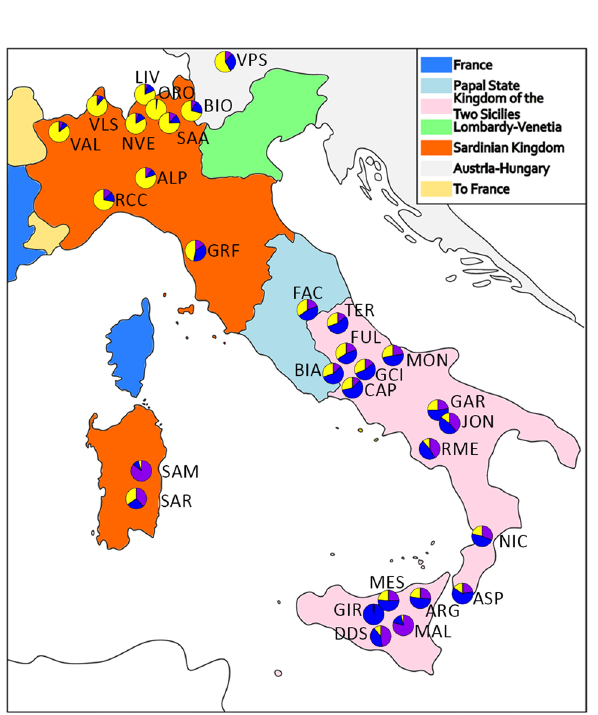
Figure 2. Historical map of Italy pre-unification with pie chart of the ADMIXTURE K = 3 values plotted on the geographical coordinates of the mean sampling location of each breed. The colours reflect the ADMIXTURE component associated with the Maltese (purple), Northern Italy Cluster (yellow), and Central-Southern Cluster (blue). BEZ and MXS were not represented due to the lack of specific geographic coordinates. MNT_I and MNT_M were excluded as extreme outliers. Map was generated in Inkscape v1.0 (https:// inksc ape. org/); the pie charts were created using R 21